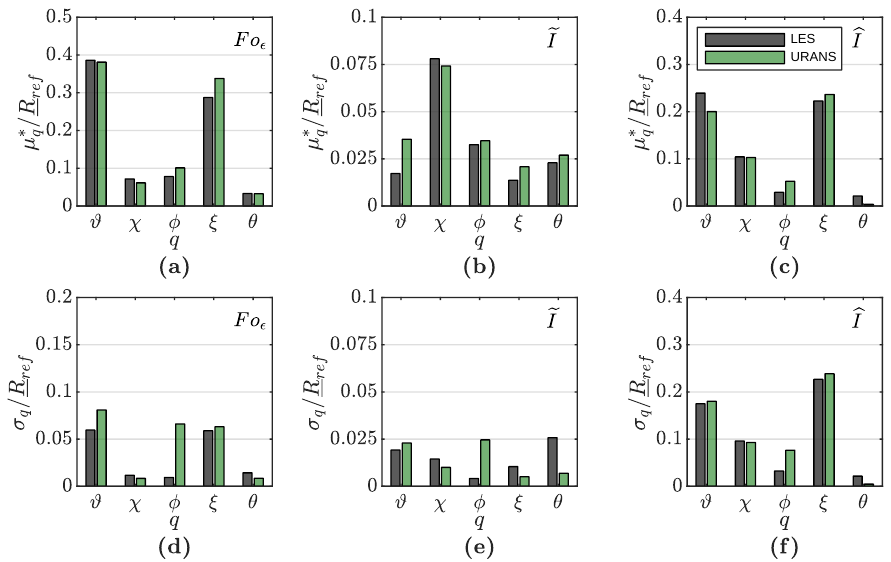
Figure 12. Normalized modified mean µ ∗ / R ref and standard deviation σ q / R ref for the responses: q ( a , d ) for the mixing time Fo (cid:101) , ( b , e ) for the integral mean segregation intensity (cid:101) I , and ( c , f ) for the mean absolute deviation to the reference case of the segregation intensity (cid:98) I